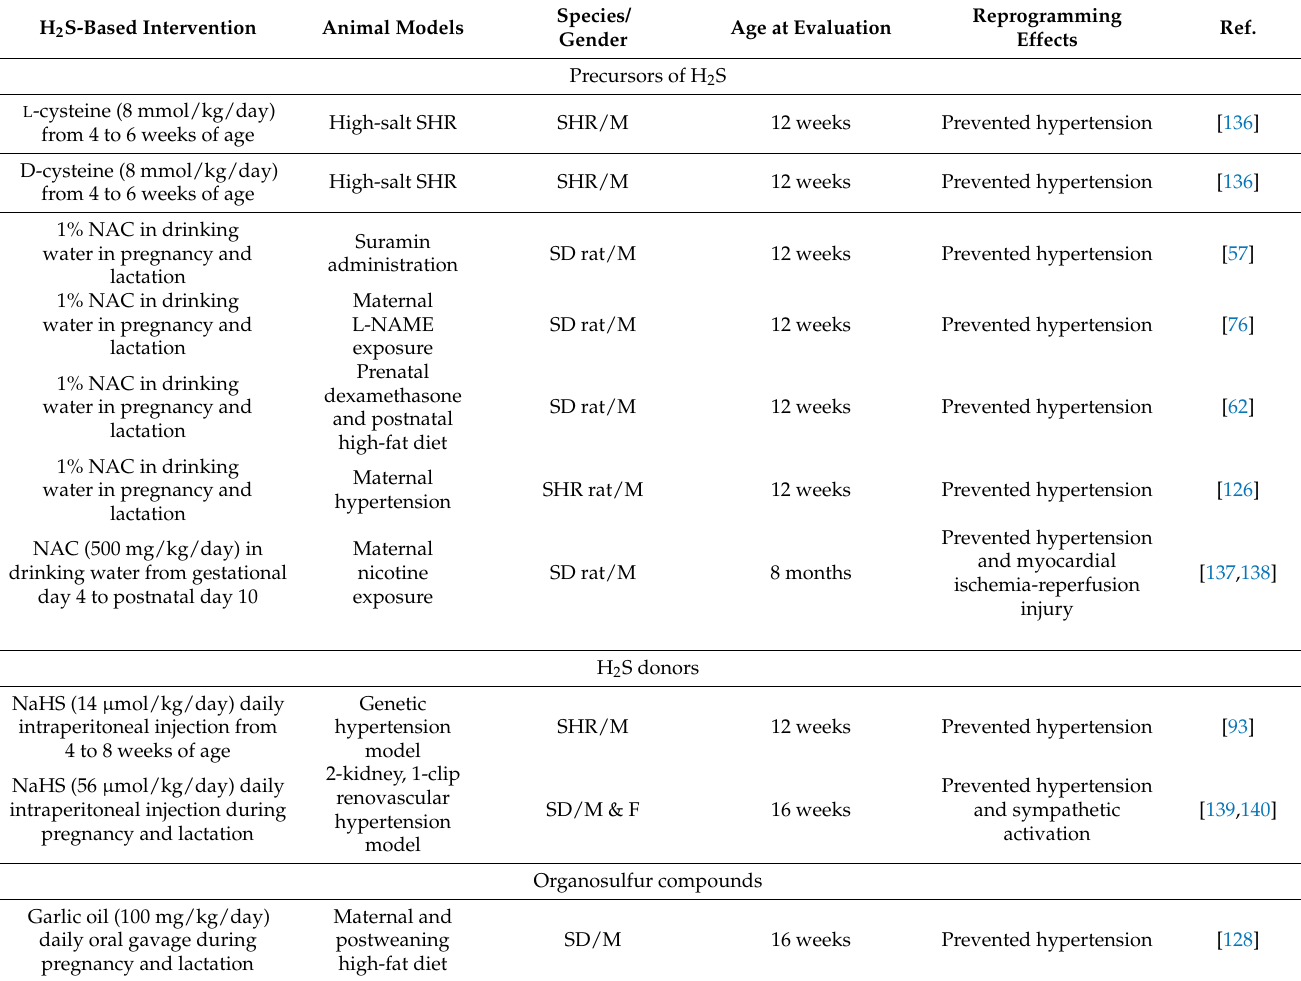
Table 1. Summary of H 2 S-based modalities used as reprogramming interventions in animal models of cardiovascu- lar